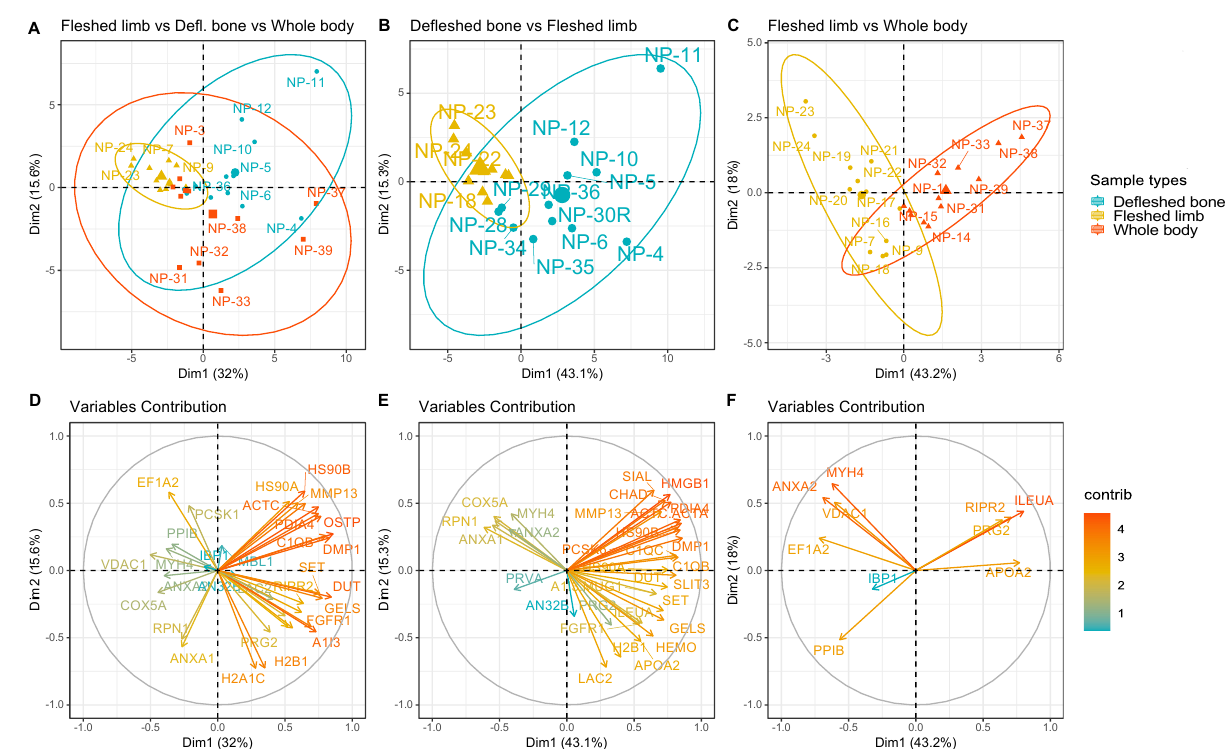
Figure 2. PCA plots (top) and variable maps (bottom) representing the samples grouped respectively in: ( A , D ) buried defleshed bones vs. exposed fleshed limbs; ( B , E ) exposed fleshed limbs vs. exposed whole bodies; and ( C , F ) buried defleshed bones vs. exposed fleshed limbs vs. exposed whole bodies. In each cluster, a bigger coordinate with the same colour was calculated as the centroids of the samples in the group. The same-coloured icons indicate the same condition. The ellipse shows a cluster categorised by the same condition (confidence interval of 0.95). Protein abundances used for the PCAs were the ones that were statistically significant according to their q